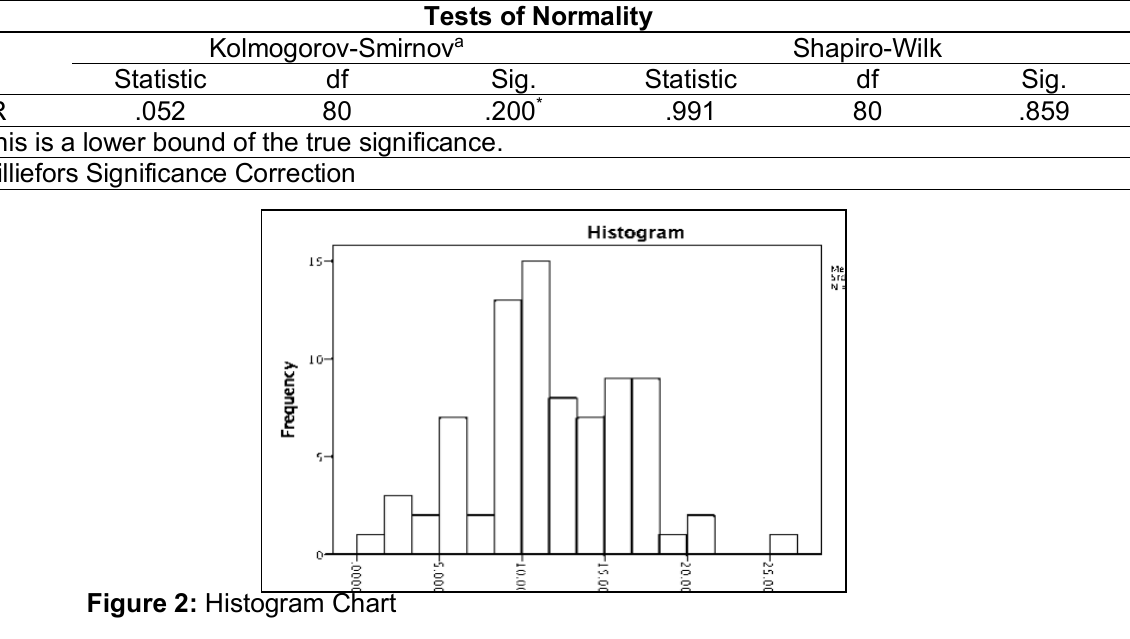
Table 3: Kolmogorov-Smirnov Test Tests of Normality